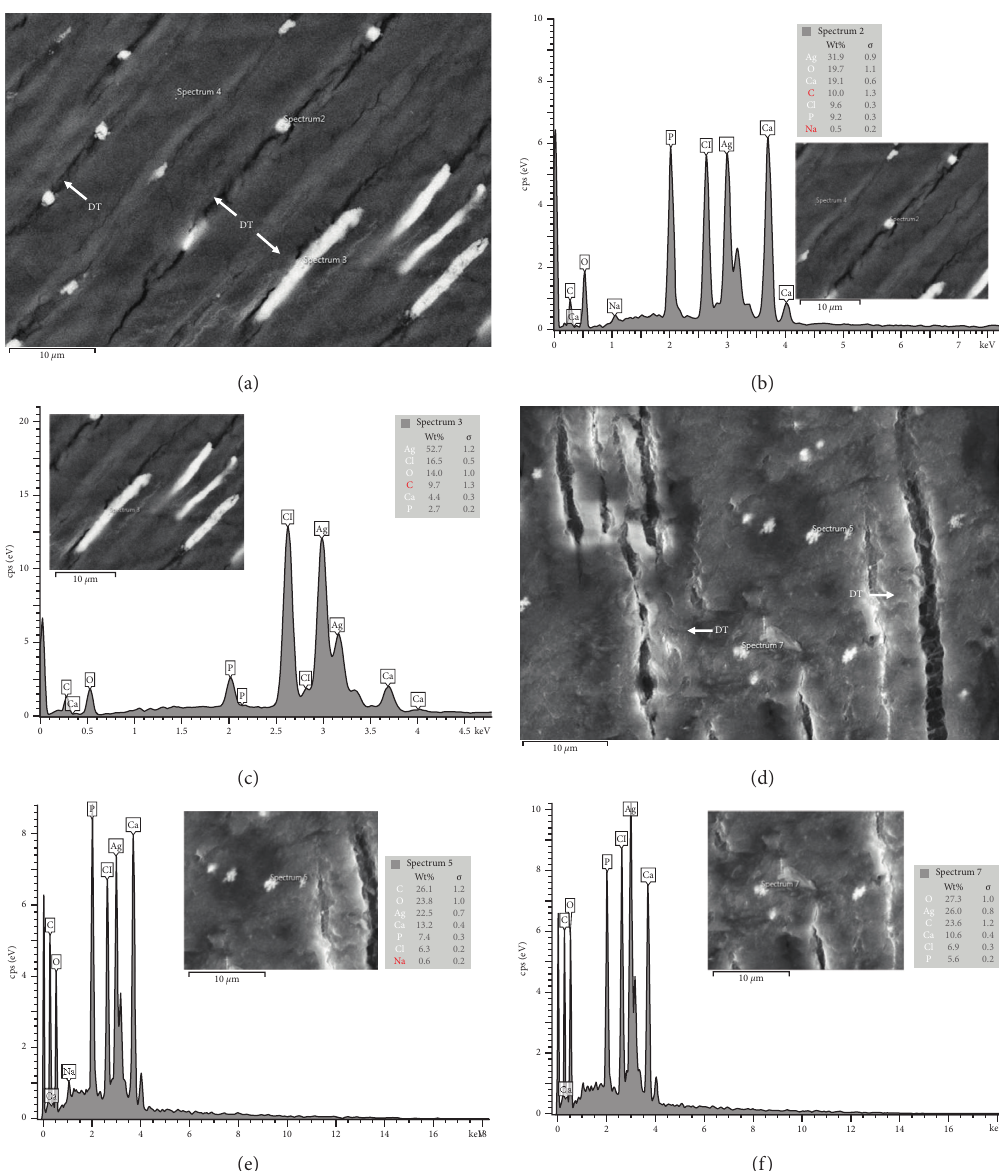
Figure 4: SEM micrographs at 3500x magnification and corresponding EDS point analysis at bright particles precipitated within tubular (a–c) and intertubular dentin